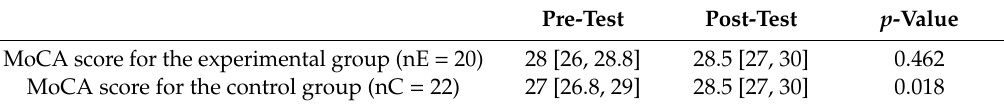
Table 2. Paired comparison between MoCA pre-test and MoCA post-test score in the experimental group and control group.